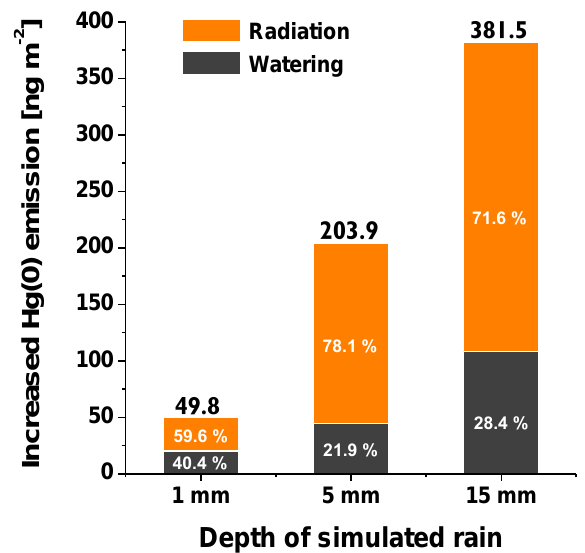
Figure 5. Increased Hg(0) emission for three different treatments (1, 5 and 15mm addition of water) compared with the 0mm treat- ment during the controlled experiment on 30 May